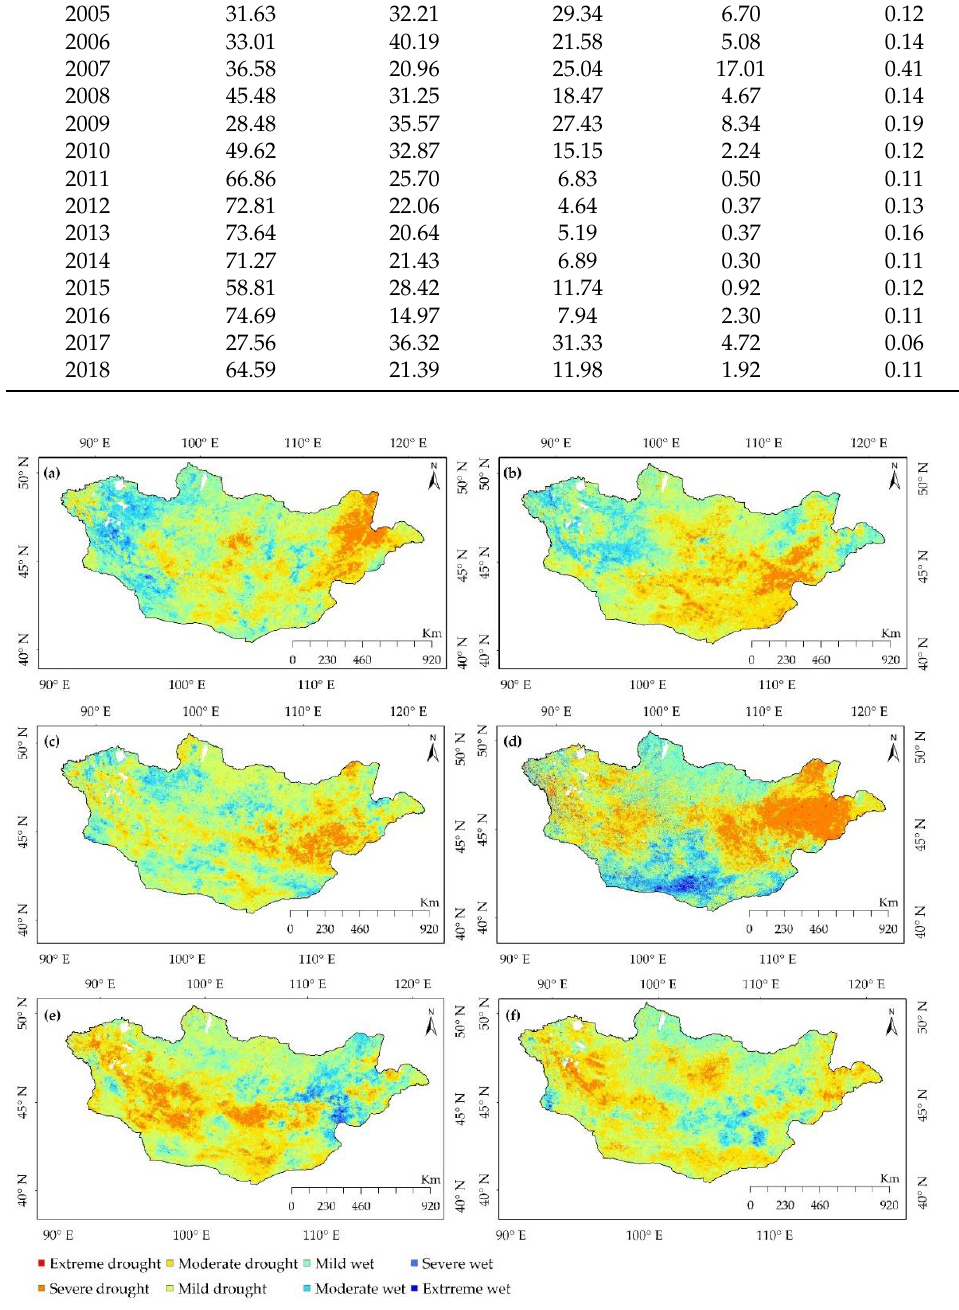
Table 4. Drought-affected area in Mongolia over the period 2003–2018. The percentage number (unit: %) indicates the drought-affected area. We assessed the effects of extensive droughts on vegetation productivity across the Mongolian rangeland by comparing the spatial patterns of growing season total NPP anomaly and drought severity. The most influential drought occurred between May to September 2017 and affected 1.13 million km 2 , covering 72.43% of the country’s land areas (Figure 5). During this drought event, severe and extreme drought areas covered approx- imately 4.71 and 0.06% and moderate and mild drought areas covered 31.33 and 36.32% of land areas of the entire country, respectively. The drought in 2004 mainly occurred in the eastern regions of Mongolia, and the drought areas covered nearly 0.94 million km 2 , which accounts for about 60% of the total land area of the country. Most of the country experienced mild (35.5%) and moderate (27.4%) drought during the 2009 drought events. The drought from May to September in 2005 mainly affected the central and southeast regions. In 2006, drought was predominant in the southwest and the eastern regions. The the year 2007. Our result was consistent with previous findings [61,62], thereby indicating that the NDVI anomaly can also be used for long-term drought monitoring in arid and semiarid regions.